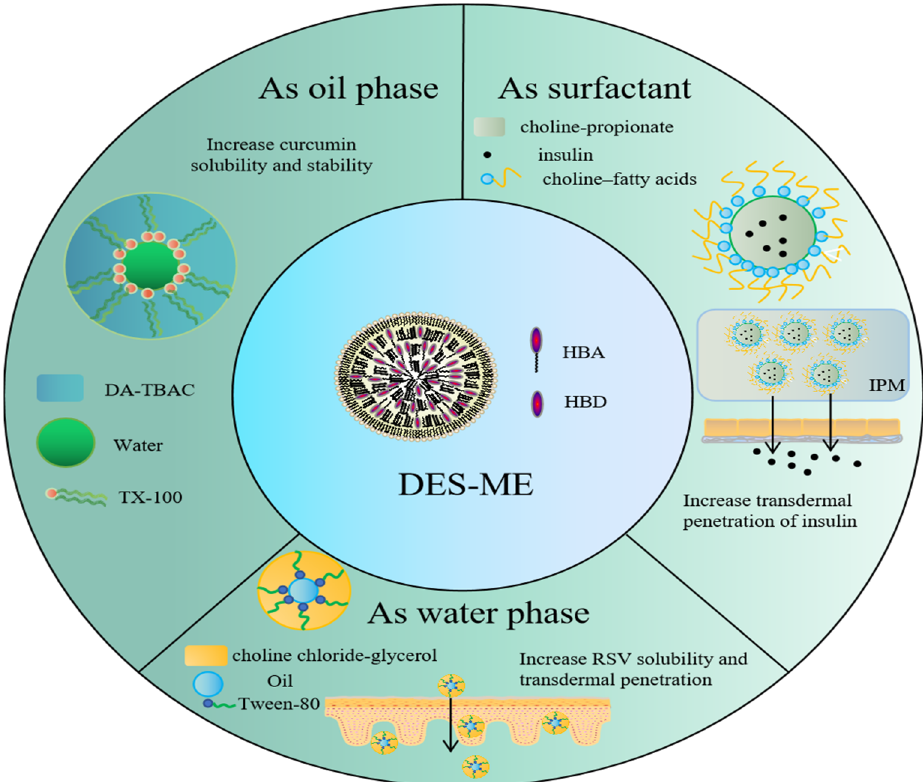
Figure 3. Applications of